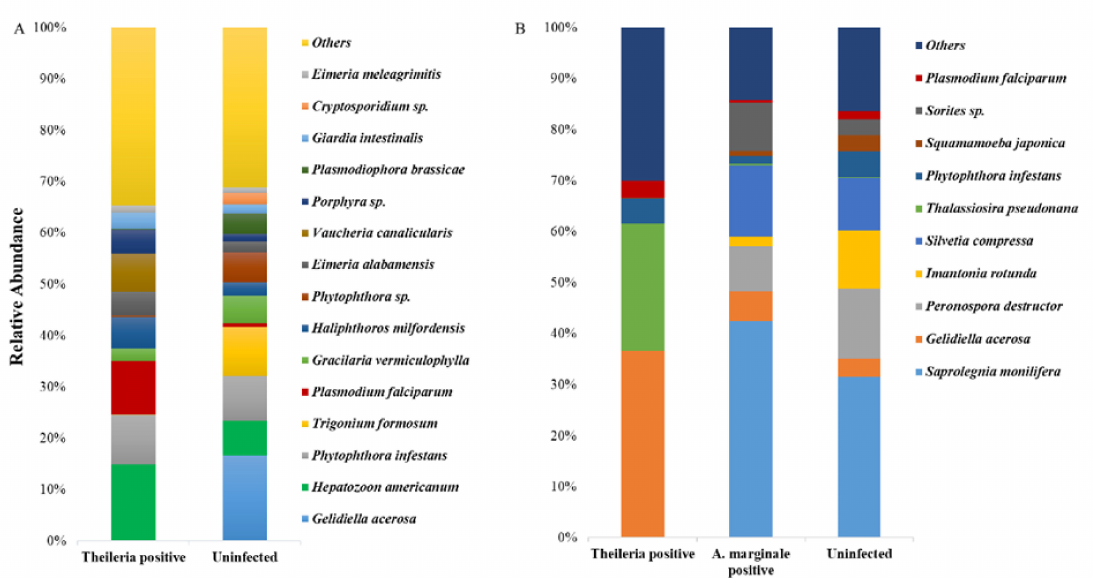
Figure 2. 18S eukaryote abundance profiles of H. anatolicum and R. microplus . ( A ) The relative abundance of identified eukaryote species from Theileria sp. positive and uninfected H. anatolicum ticks. ( B ) The relative abundance of identified eukaryote species from Theileria sp. positive, A. marginale positive, and uninfected R. microplus